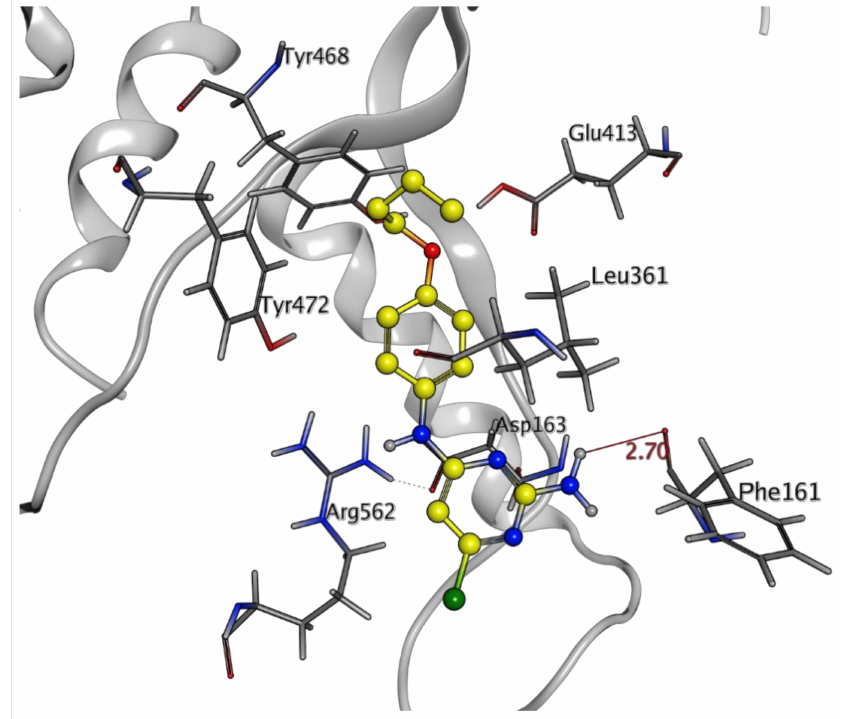
Figure 8. Molecular interaction map of moderate active compound 8 (yellow) displaying very few electrostatic (red line) and hydrophobic interactions with noncrucial residues within the binding pocket of the β -glucuronidase enzyme.